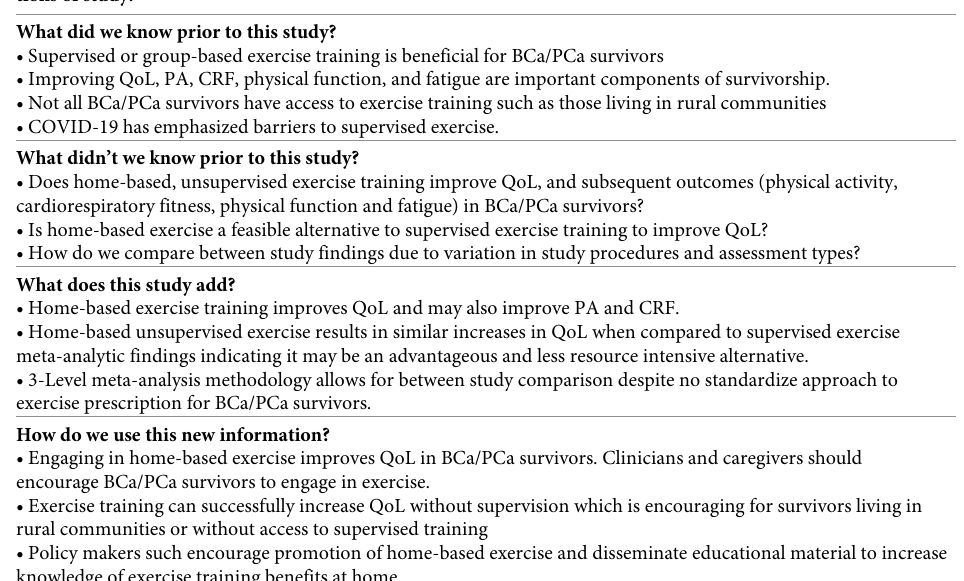
S1 Fig. Funnel plot of observed outcomes (standardized mean difference) for quality of life. Description. Funnel plot constructed using 3-level model. Includes k = 17 studies, u = 23 effect sizes, and total sample of n = 657. Regression intercept test constructed by specifying the standard error of the observed outcomes as a moderator in a 3-level model. Interpretation.